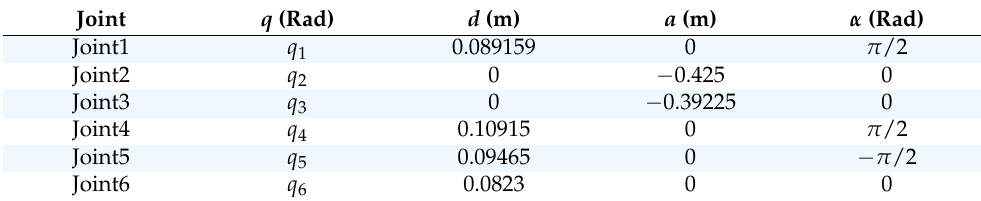
Table 1. DH parameters of the UR5 manipulator. Joint